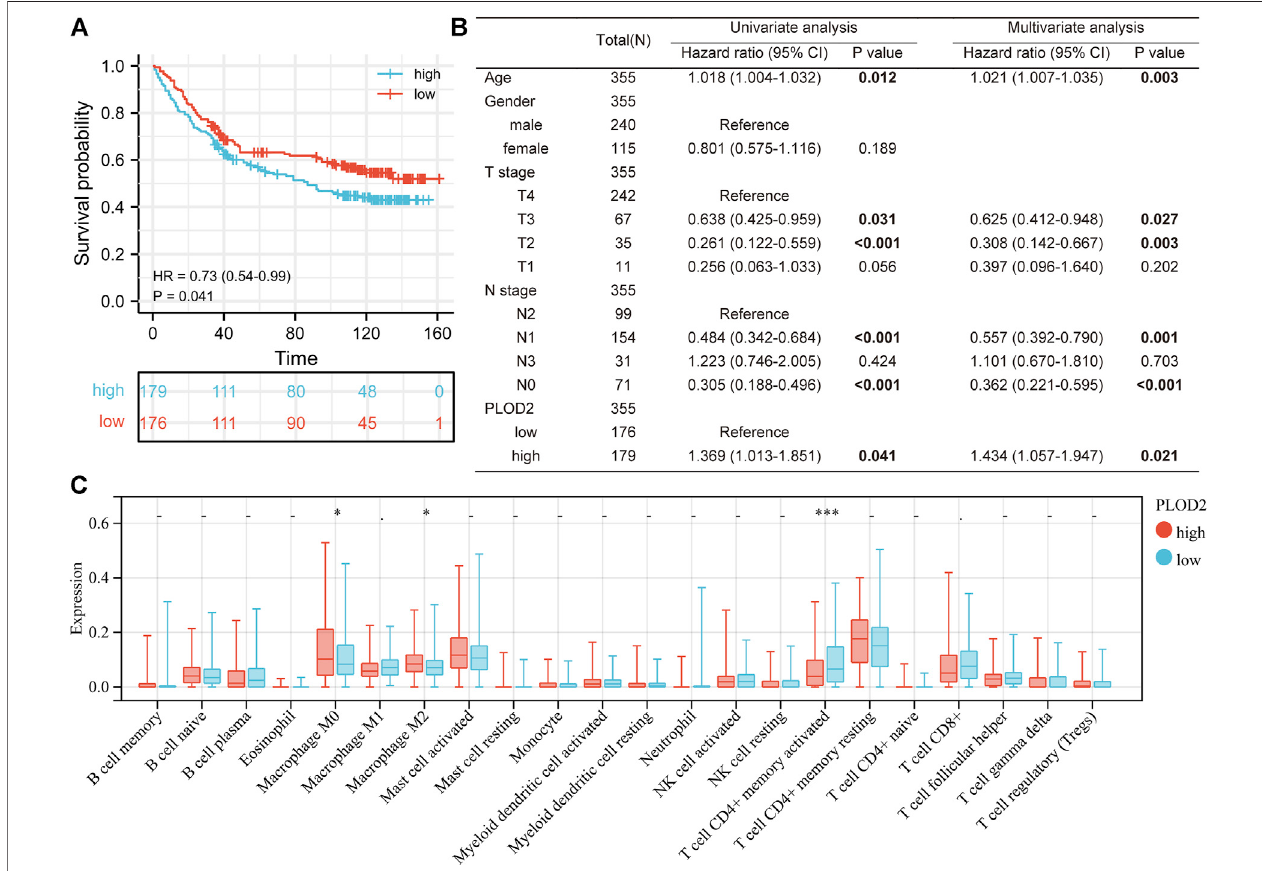
FIGURE 7 | Validation PLOD2 expression in GSE84433 cohort. (A) survival curve of high and low PLOD2 expression. (B) univariate and multivariate analysis of overall survival in GSE84433 cohort. (C) immune in fi ltration difference between high and low PLOD2 expression in GSE84433 cohort, based on CIBERSORT deconvolution